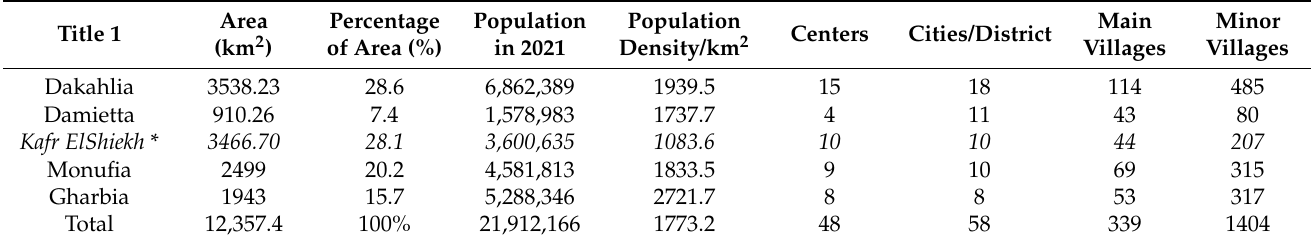
Table 2. The demographic data (reference year 2021) and the administrative structure of the gover- norates of the Delta region [98,99].